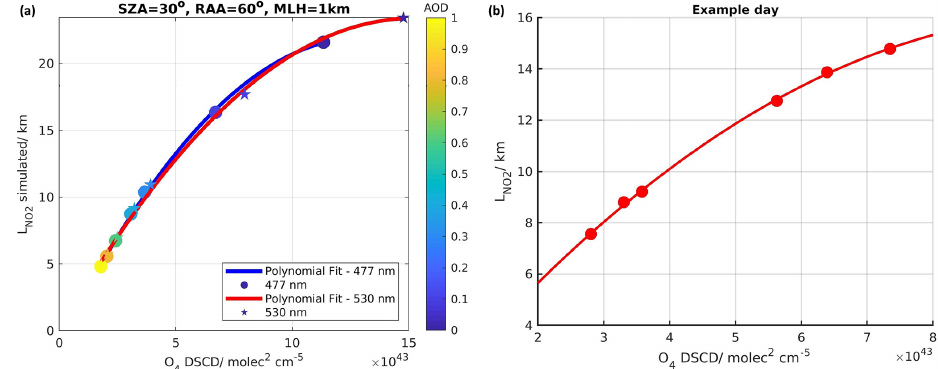
Figure 5. (a) Dots (stars): simulated L NO for NO 2 box profile of 1 km at 477nm (530nm) for an SZA of 30 ◦ and RAA of 60 ◦ as a 2 function of the simulated O 4 dSCDs for the different AOD values (1, 0.8, 0.6, 0.4, 0.3, 0.1, and 0; see Table 2). Blue (red) line: second-order polynomial fit through the data points. (b) Dots: estimated L NO in the six wavelengths used in the retrieval for 1 example day (11 September 2 2018). Red line: fitted line through the data